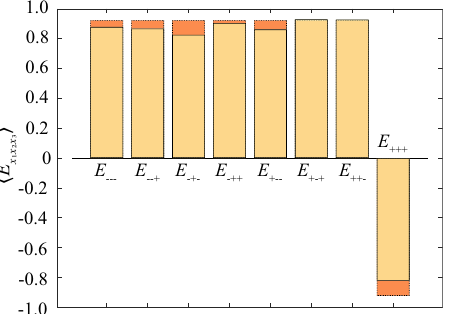
Fig. 3 Experimental results. Experimentally measured correlation terms belonging to the non-local Bell inequality in the GYNI where { x 1 , x 2 , x 3 } = ± 1. Orange bars represent the scenario, E x 1 x 2 x 3 theoretical values assuming the optimal measurement settings while yellow bars show the experimentally observed values. We evaluate the inequality and report a correlation value of B G = 7.023 ± 0.036. Errors as estimated by Monte Carlo sampling, using N = 200 runs and assuming Poissonian statistics, are omitted as they are to small too be visible.